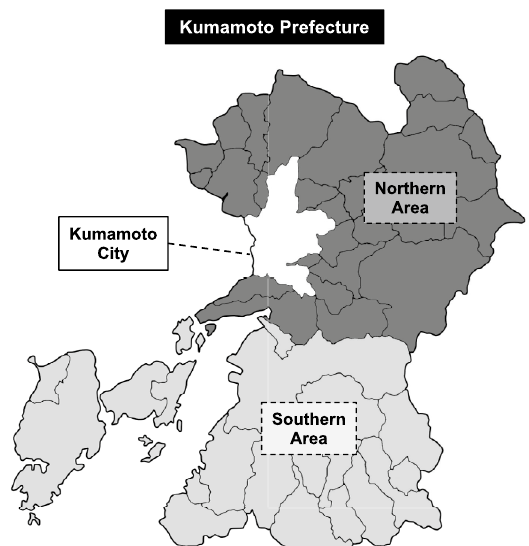
Fig. 1 Area classification of Kumamoto